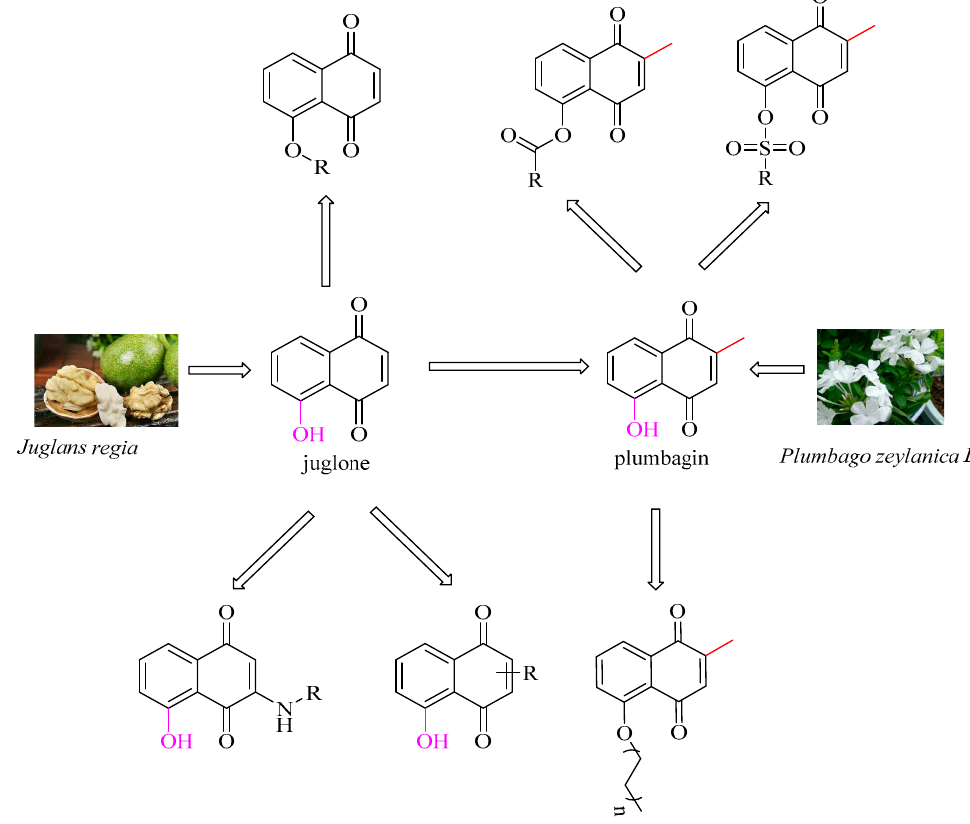
Figure 1. Molecular design and structural optimization based on plumbagin ( I ) and juglone ( II ).